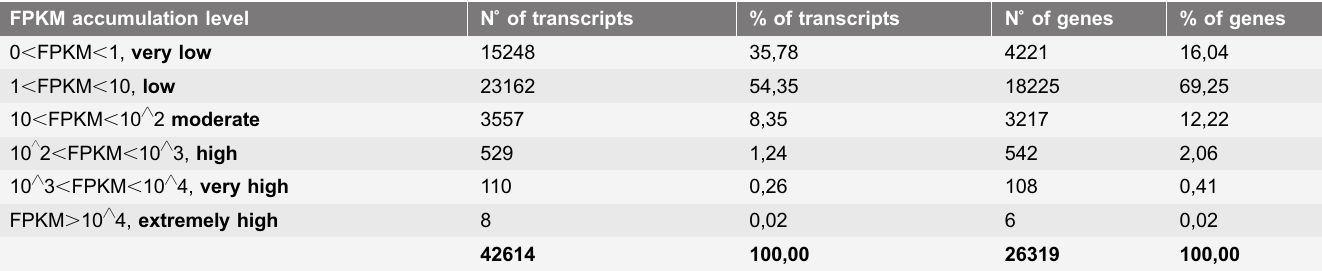
Table 3. FPKM distribution of the MEET data